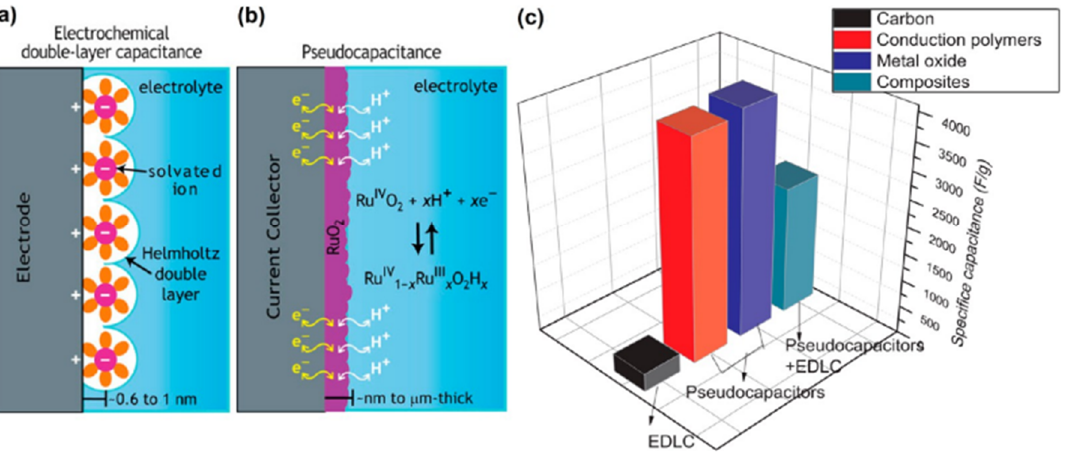
Figure 5. Charge storage mechanism through the process of ( a ) EDLC. ( b ) Pseudocapacitance Reprinted with permission from ref. [103]. Copyright 2011 Materials Research Society. ( c ) Difference between the latest SC application materials. Reprinted with permission from ref. [104]. Copyright 2018 Elsevier.